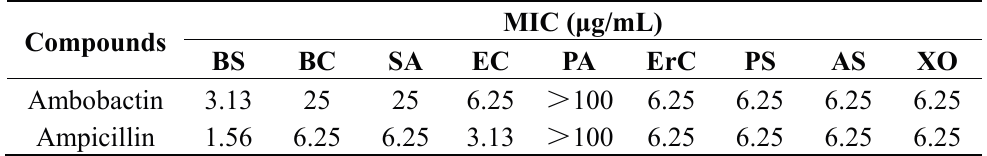
Table 3. Antibacterial activity of ambobactin ( 1